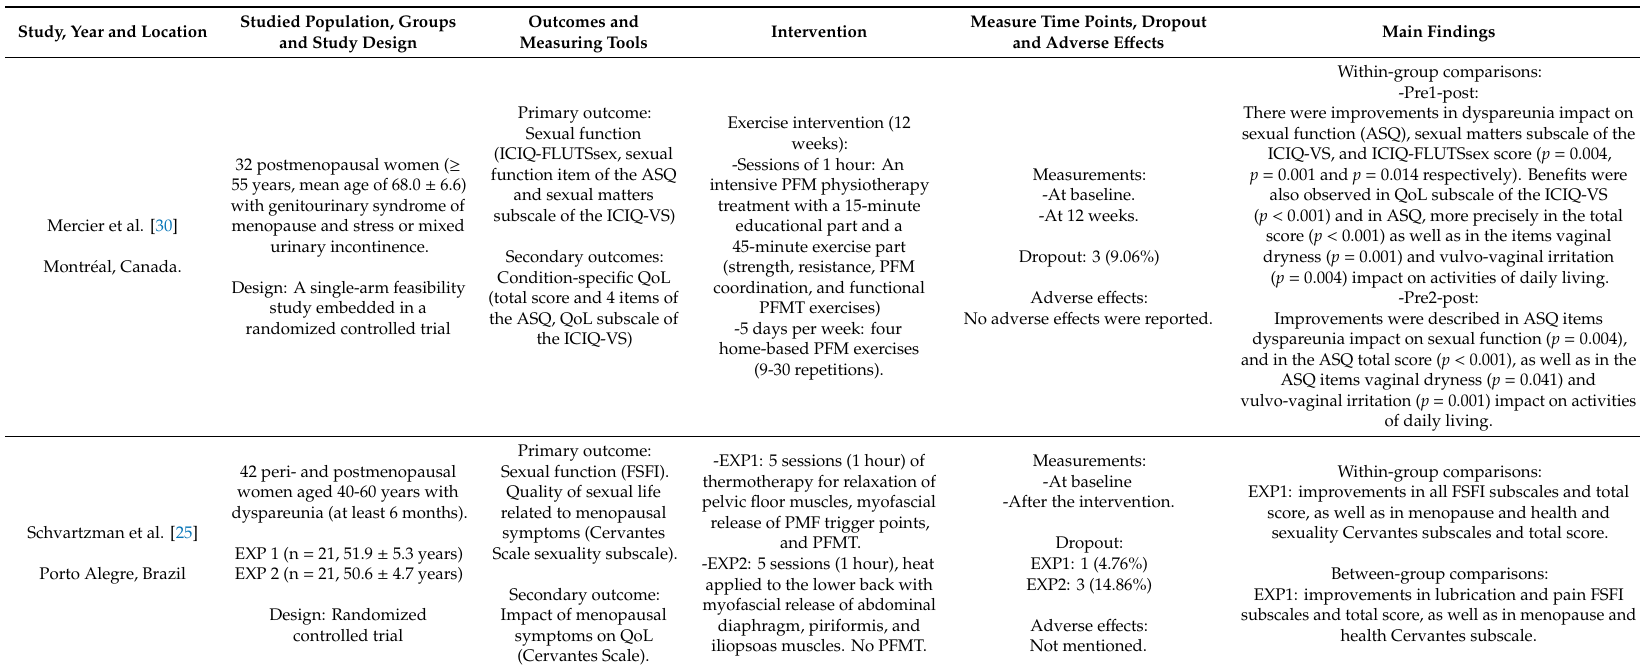
Table A1. Characteristics of the included studies (n =